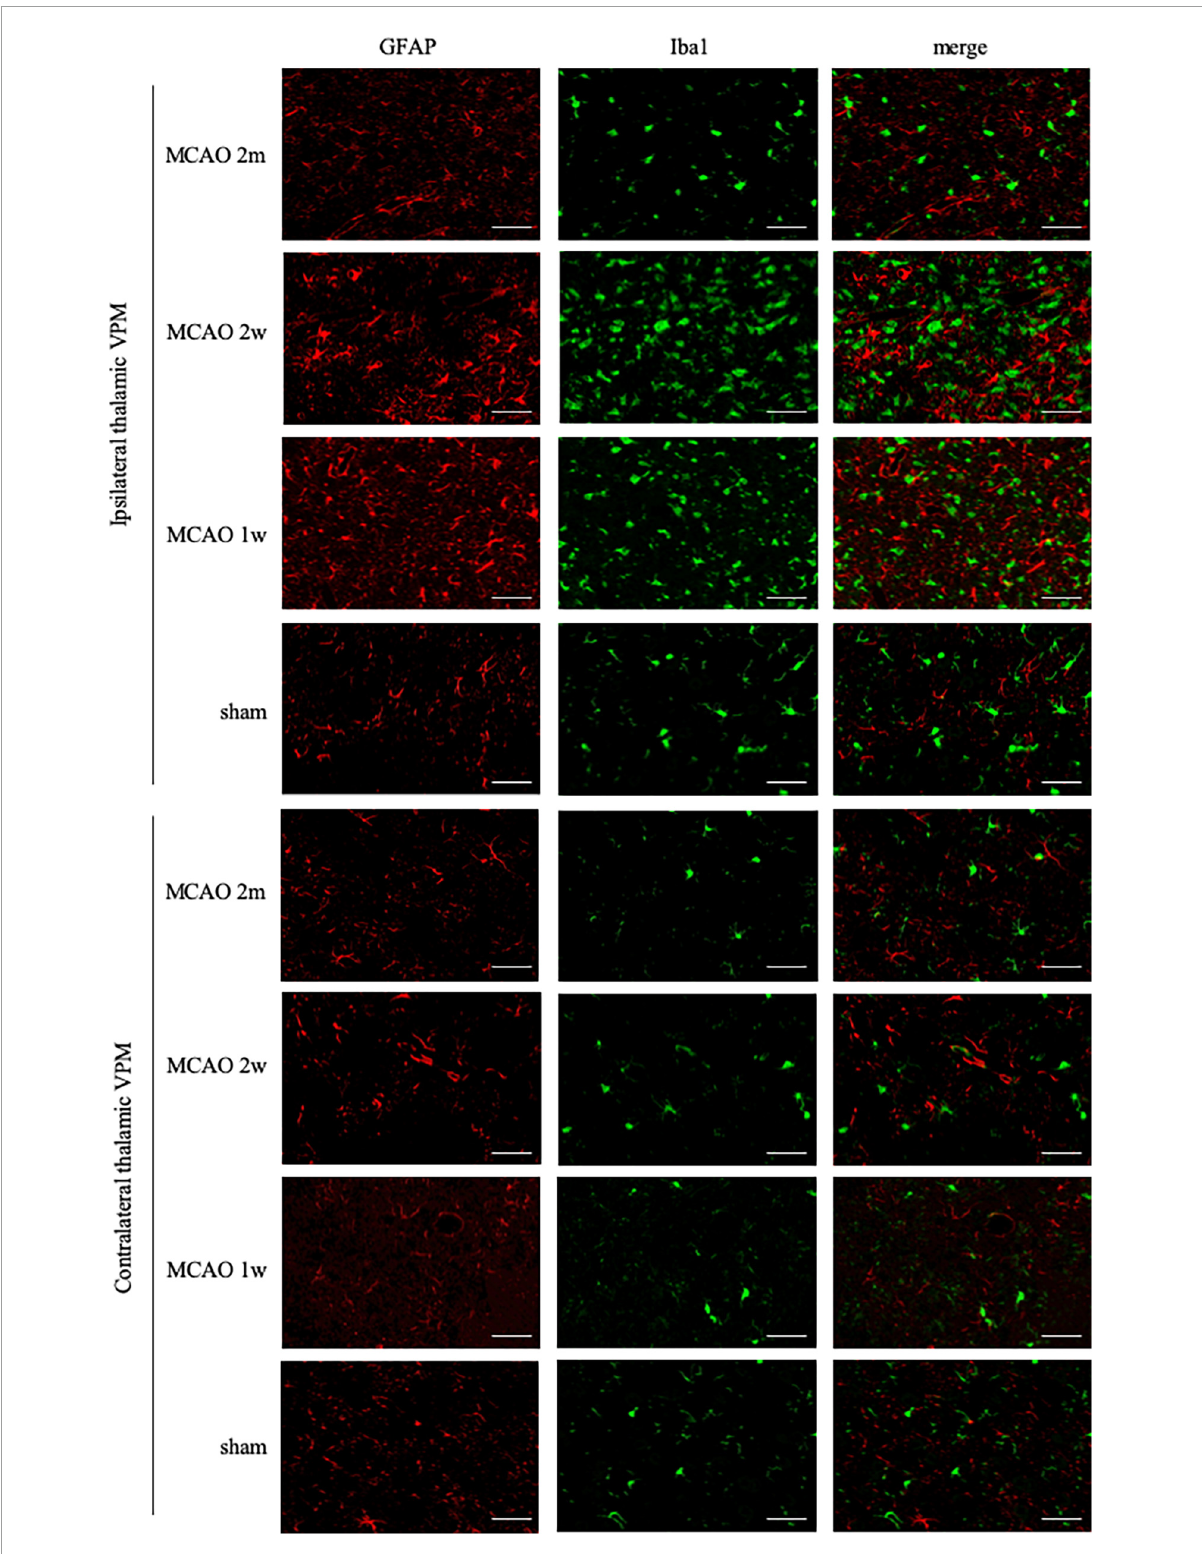
FIGURE4 GFAP + Iba1 double-label staining in the thalamus VPN. Microglial activation (Iba1, green) was obvious in the ipsilateral thalamus VPN at the 1st week, the 2nd week, and the 2nd month after MCAO, compared with the contralateral thalamus VPN. Bar = 50 µ m. GFAP, glial fibrillary acidic protein; Iba1, ionized calcium-binding adaptor molecule 1; VPN, ventroposterior nucleus; MCAO, middle cerebral artery